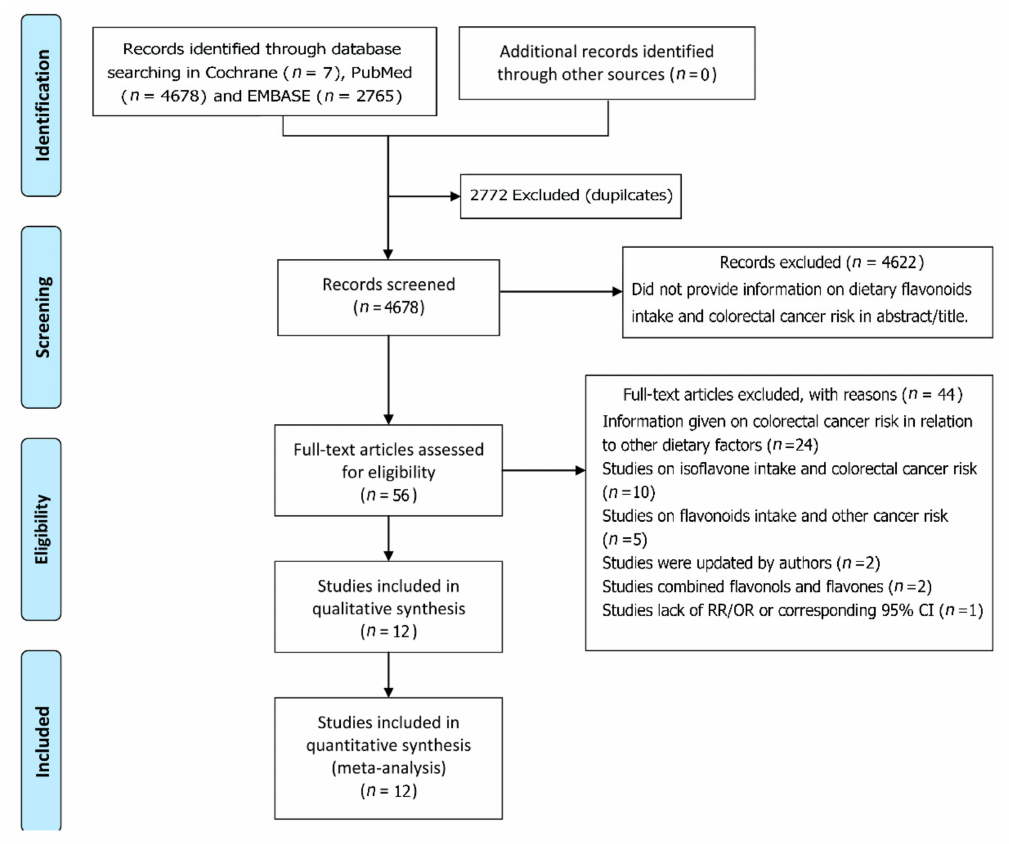
Figure 1. Flow chart showing study selection